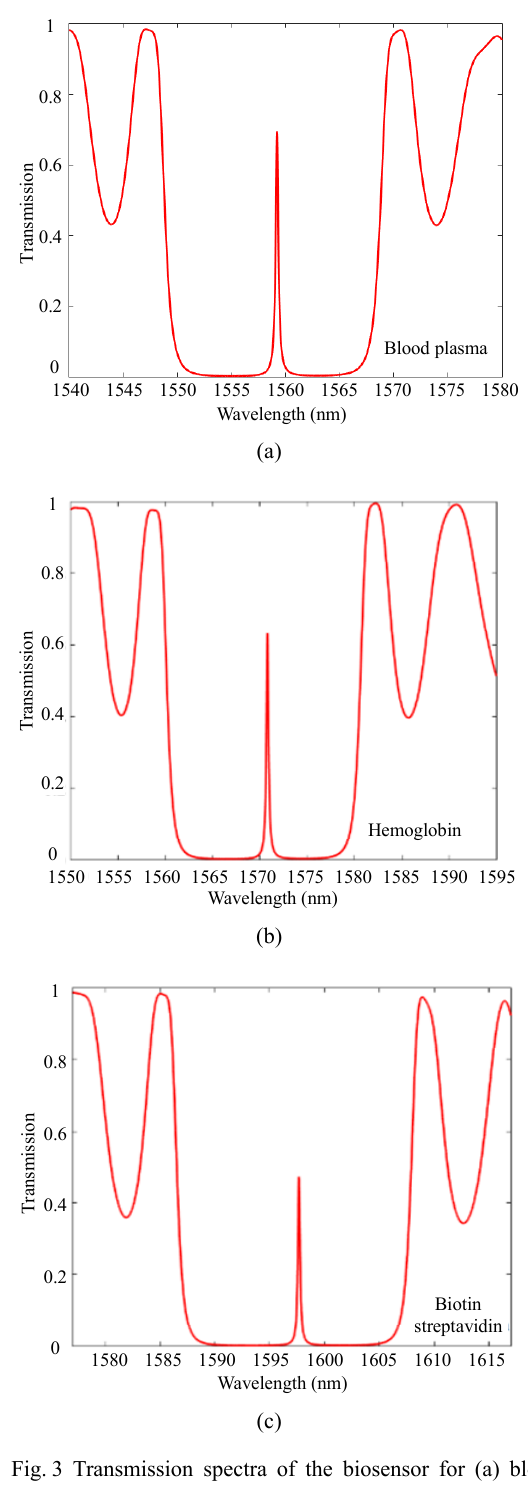
Fig. 3 Transmission spectra of the biosensor for (a) blood plasma, (b) hemoglobin, and (c) biotin-streptavidin.